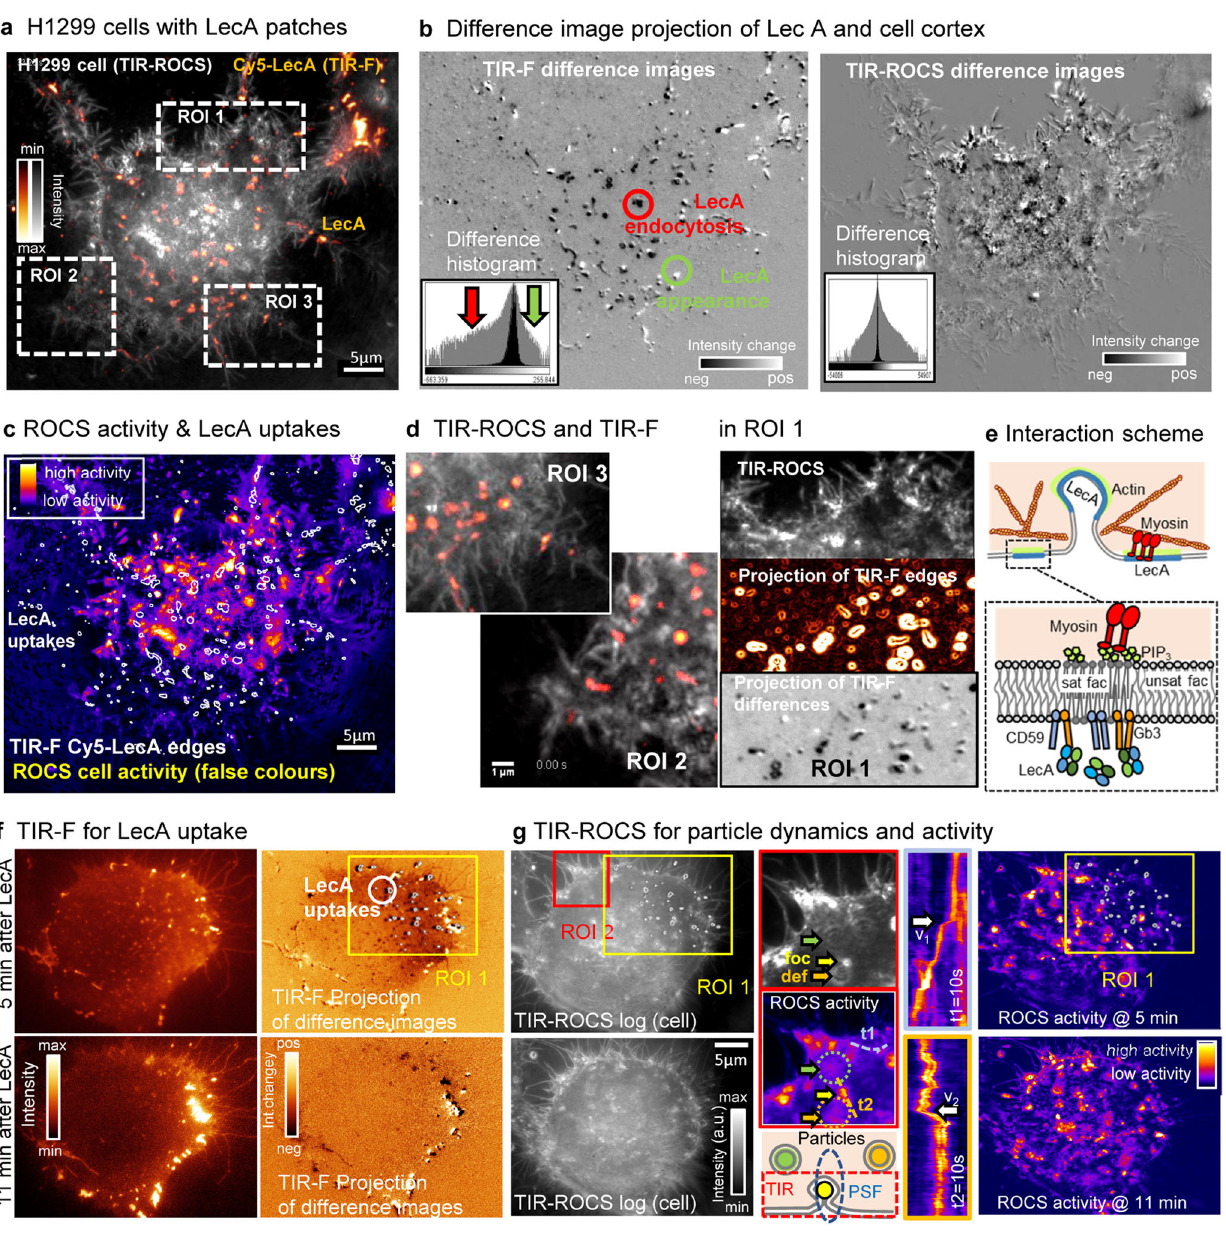
Fig. 7 ROCS microscopy of LecA dynamics at the outer cell cortex. a TIR-ROCS image (10 ms integration time) of a H1299 lung carcinoma cell in gray colors overlaid with TIR- image (50 ms integration time) of LecA clusters (Cy5) in orange colors. b Difference images averaged over 10 s show dynamics of LecA clusters (TIR-F) and (TIR-ROCS). The difference histogram is asymmetric, negative biased for TIR-F indicating enhanced endocytosis. Negative (positive) differences in black (white) correspond to endocytosis (exocytosis). c TIR-ROCS activity map over 10 s and full 100 Hz bandwidth show cell cortex dynamics relative to edges of LecA TIR-F images. d Regions of interest ROI 3, ROI 2 (see Supplementary Movies) and ROI 1 from fi gure above show cell cortex details (ROCS), the occurrences of Cy5-Lec A clusters (edge enhanced) and the LecA dynamics by TIR-F difference averaged over 10 s. e Sketch of membrane invagination and transport of LecA along actin fi bers through myosins. Outside the membrane LecA binds to Gb3 and CD59, which loosely connects through the membrane to long saturated fatty acid chains of PIP3 and myosin. f Imaging of LecA with 2 Hz TIR-F after 5 min and 11 min of LecA addition. TIR-F differences averaged over 10 s reveal several uptake events (black patches and corresponding white edges, right-shifted). g TIR-ROCS imaging of H1299 cell after 5/11 min of LecA addition with white edges in ROI 1 from LecA uptake areas in f. ROI 2 shows one (foc)ussed particle (yellow arrow) at membrane and two (def)ocussed particles inside the cell, which cause activity as well (dashed circles in activity ROI below). The kymographs along t1 and t2 depict stop-and-go diffusion with maximal velocities v 1 and v 2 (white arrows). Activity plots at 5/11 min show high particle dynamics at the membrane and in the cortex. Source data are provided as a Source Data fi